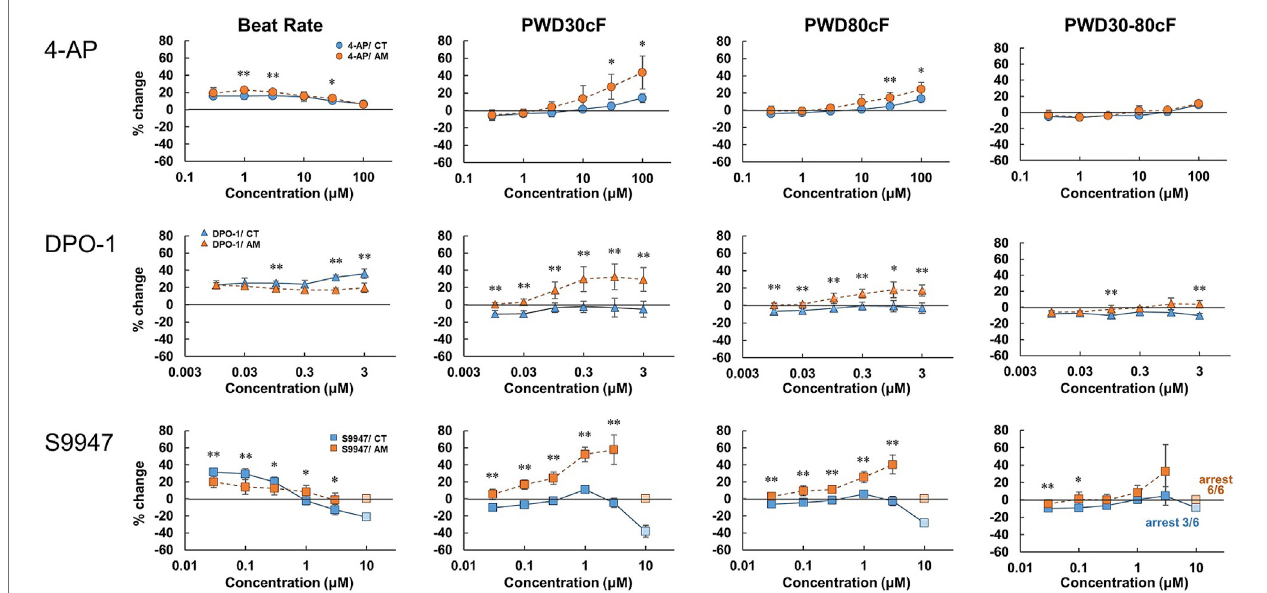
FIGURE 4 | Dose-response of I Kur channel blockers in CT and AM. CT and AM were treated with various concentrations of 4-Aminopiridine (4-AP), DPO-1, and S9947,and MPwasanalyzed byFDSS/ μ Cellimagingplatform. Y -axis representsthepercentage changefromthe valuebefore testcompoundaddition.Comparison of MP parameters: beat rate, PWD (Pulse width duration) 30cF, PWD80cF, PWD30-80cF in CT and AM. Error bars represent SD of the mean from the values of independent experiments. n (cid:2) 6, * p < 0.05, ** p < 0.01 for comparison of drug treatment of CT vs. AM. DPO-1 data: reuse from the conference paper with permission (Honda, 2020).